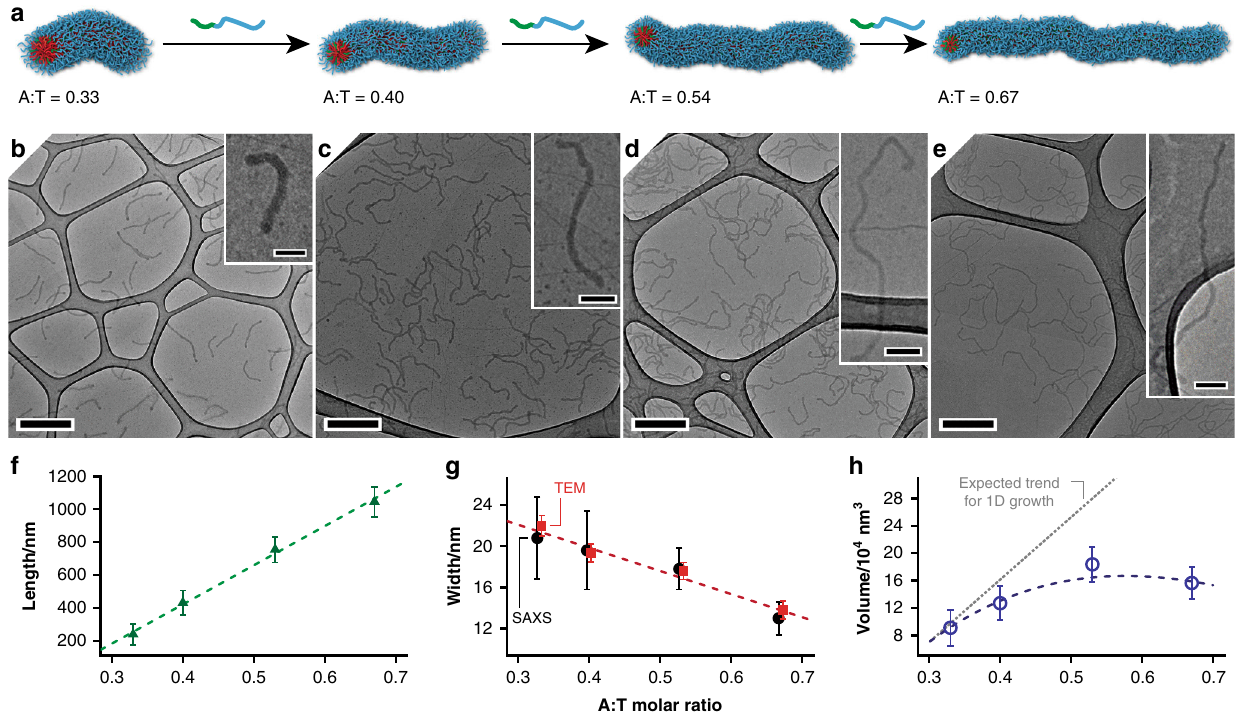
Fig. 3 Stepwise growth of well-de fi ned anisotropic nanoparticles by MORPH. a Schematic representation and b – h characterisation of the wormlike nanoparticles. b – e Stain-free TEM images of the nanoparticles at different A:T molar ratios; the scale bars in ( b – e ) and their insets are 500 and 100 nm, respectively. Average lengths ( f ), widths ( g ) and volumes ( h ) of the worms from analyses of TEM images ( b – e ) and SAXS. Note that the TEM and SAXS data in g have been offset for clarity. Error bars represent one standard